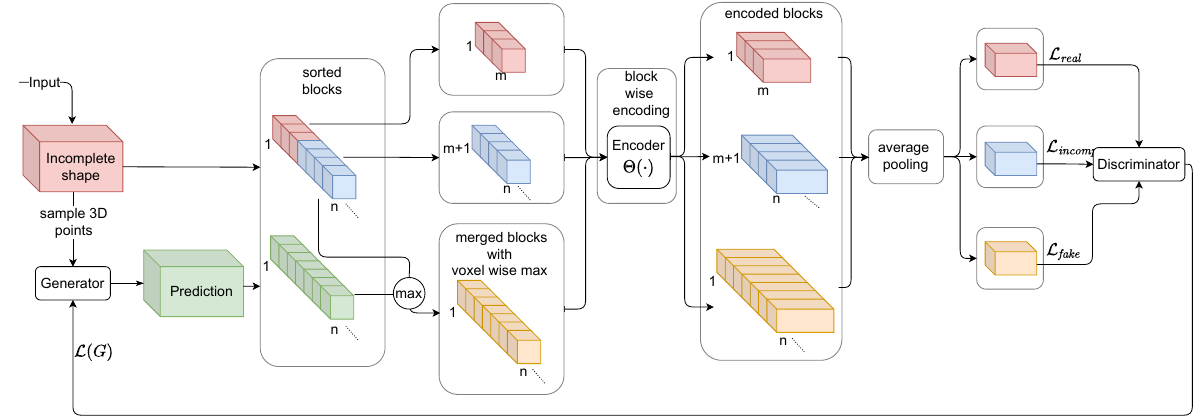
Figure 2. Methodology: Red/blue and green color indicate real and generated data, respectively. Orange blocks are merged voxel-wise between real and synthesized, indicated by the max operation. The Encoder Θ( · ) is shown in Figure 4. It encodes each block into a vector which are then average pooled to a fixed size representation and passed to the